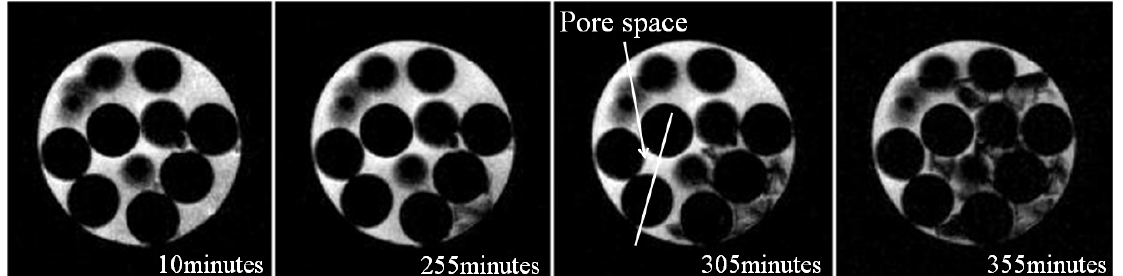
Figure 8. The images of the THF hydrate growth in one of the cross sections with time in 5.7% THF